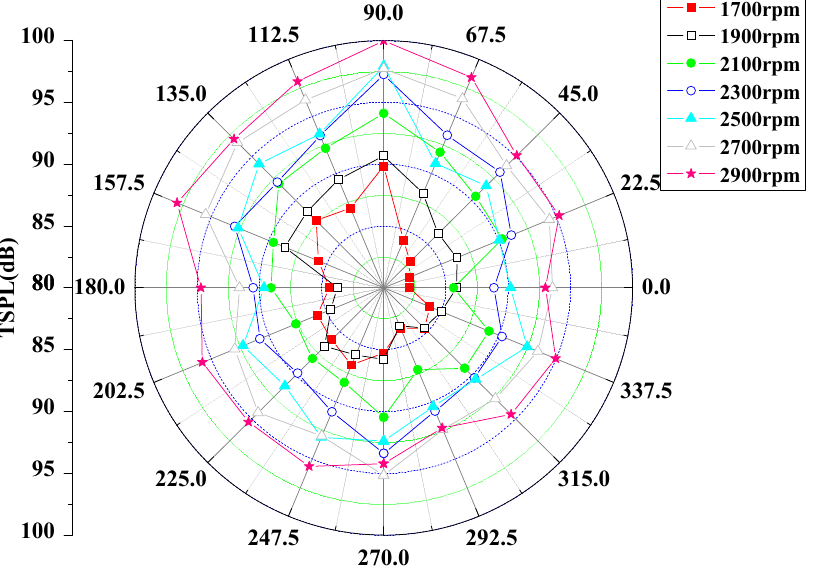
Figure 5. Directivity characteristic of radiation noise under various rotational speed conditions.